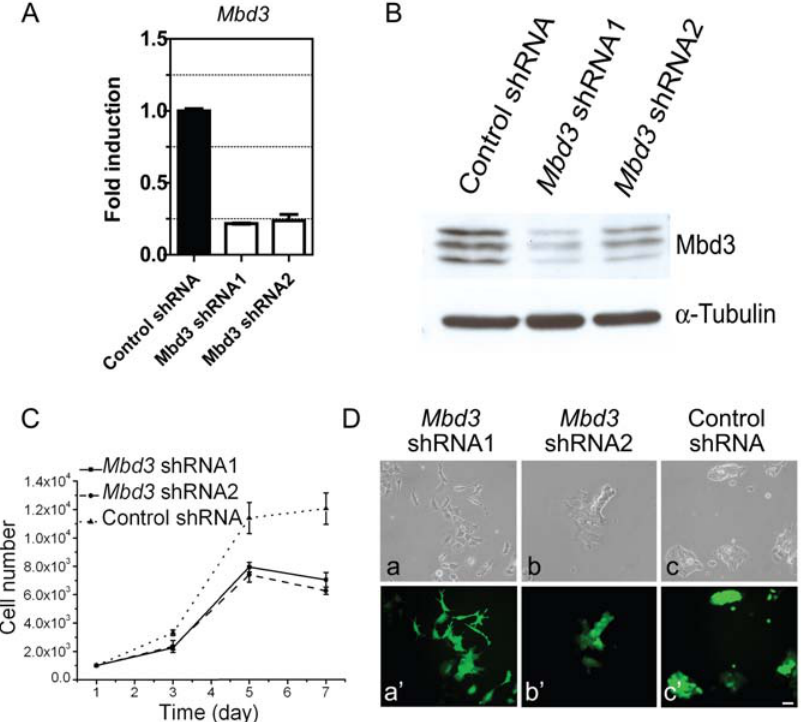
Figure 1. Reduced Mbd3 expression in CGR8 cells results in morphological differentiation. A) Quantitative RT-PCR analysis Mbd3 mRNA expression in Mbd3 shRNA transfected CGR8 cells, which were selected with puromycin for five days. Gene expressions are normalized to internal control b -actin and presented as the fold induction relative to control shRNA. Error bars represent standard deviation from three technical repeats. B) Mbd3 shRNA transfections downregulates endogenous Mbd3 protein expression in CGR8 cells detected on western blots. Cells were transfected with indicated shRNA plasmids. C) Growth curves of CGR8 cells transfected with shRNA plasmids. Only GFP positive cells were counted. Error bars represent standard deviation. D) CGR8 cells were transfected either with control shRNA(a, a 9 ) or Mbd3 shRNA1/2 (b, b 9 and c, c 9 ) and selected for five days with puromycin. GFP fluorescence in a 9 , b 9 , c 9 indicate that the cells harbor shRNA plasmids. The scale bar represents 50 m m.